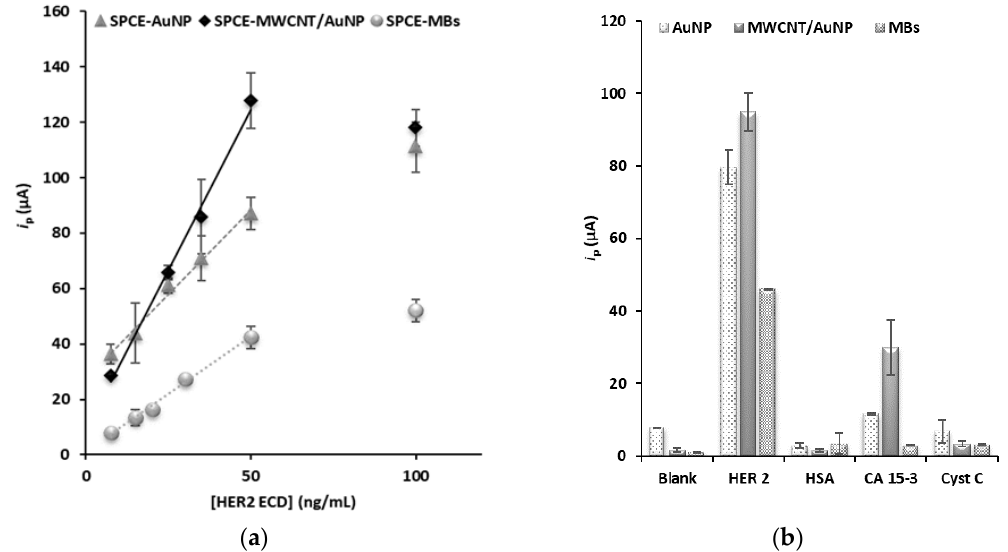
Figure 2. ( a ) Calibration plot in Human serum using SPCE-AuNP, SPCE-MWCNT/AuNP and SPCE-MBs; ( b ) Selectivity studies using other serum